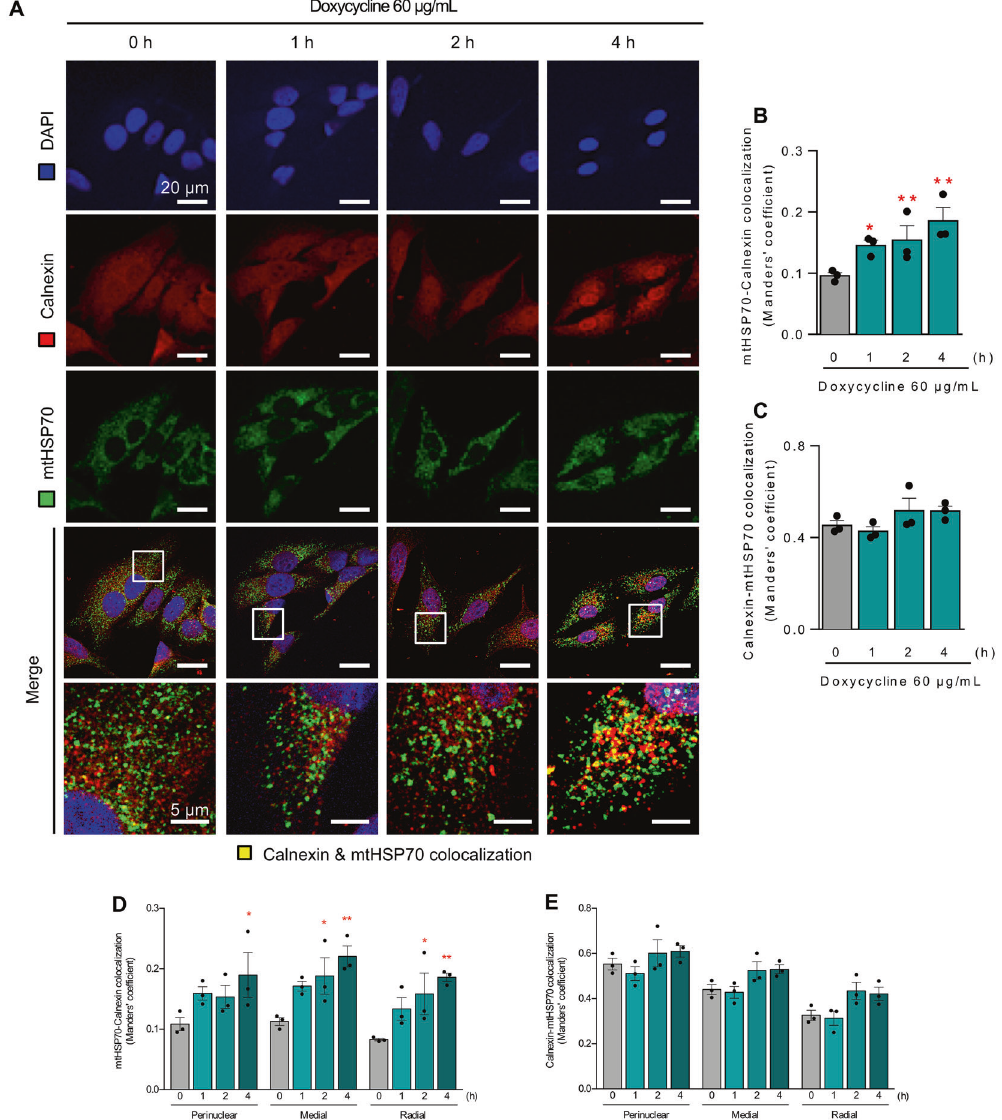
Fig. 1 Doxycycline increases ER-mitochondria colocalization in a global fashion. HeLa cells were treated with 60 µg/mL doxycycline for the indicated times. A The ER was stained with anti-calnexin antibody (shown in red), mitochondria were stained with anti-mtHsp70 antibody (shown in green), and the nucleus was stained with DAPI (shown in blue) and then imaged using confocal microscopy. Colocalization is shown in yellow in the merged images. Scale bars: 20 and 5 µm (magni fi cation). B Mitochondria-to-ER colocalization was quanti fi ed as Manders ’ coef fi cients of images obtained in panel ( A ). C ER-to-mitochondria colocalization was quanti fi ed as Manders ’ coef fi cients of images obtained in panel ( A ). D , E Quanti fi cation of the mitochondria-to-ER and ER-to-mitochondria Manders ’ coef fi cients in the prede fi ned subcellular regions ( n = 3). Results are shown as mean ± s.e.m. * P < 0.05 and ** P < 0.01 versus control